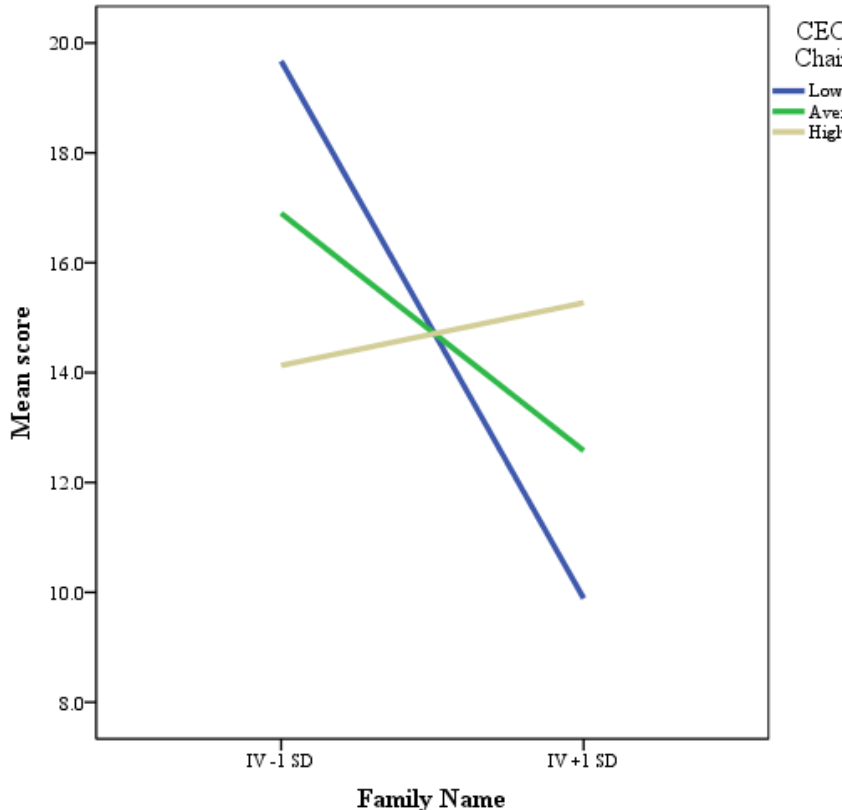
Figure 3. Interaction Plot: Family Name and CEO